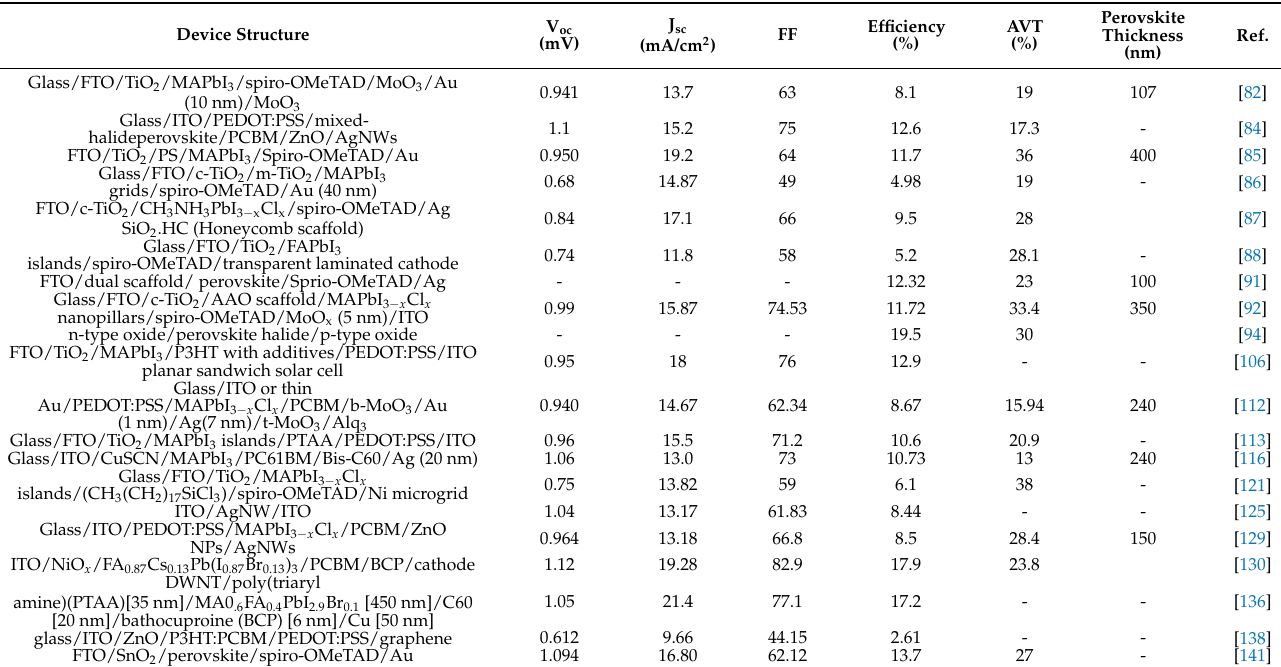
Table 1. Best efficiencies of flexible perovskite solar cells with different architecture. Device